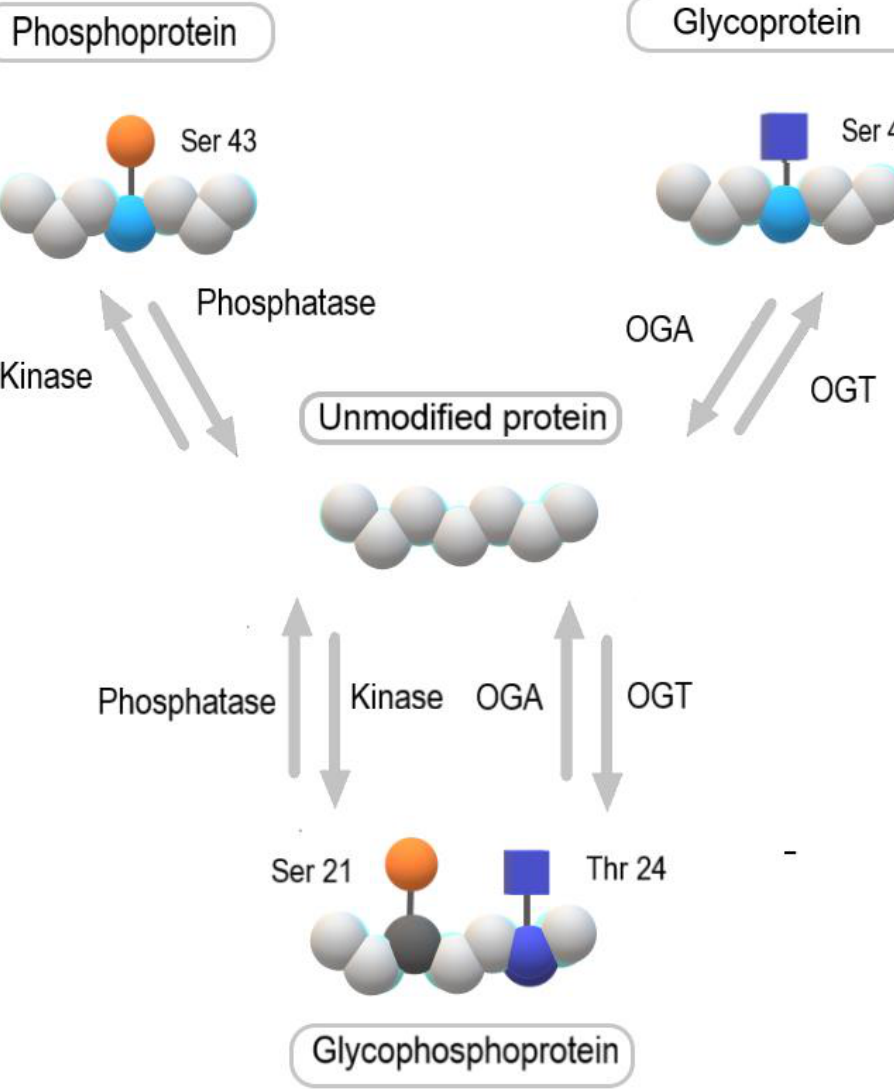
Figure 4. The crosstalk between O-GlcNAcylation and phosphorylation of serine and threonine residues, and the antagonistic relation between OGT-kinase and OGA-phosphatase.